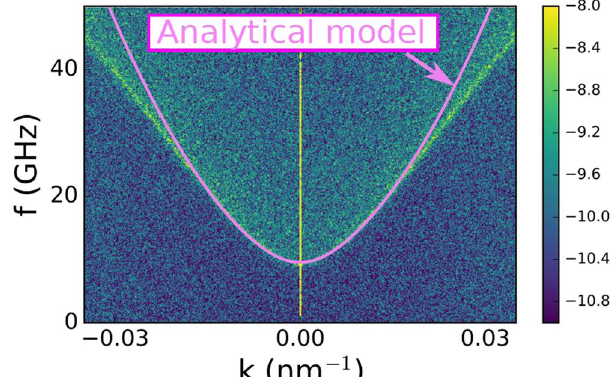
Figure 8. Simulations (color scale of the 2D FFT amplitude, a.u.) and analytic calculation (line) of the dispersion relation of spin waves propagating in a semi-infinite (periodic boundary conditions in one direction) plane, 1 nm thick (to allow a comparison with the analytical model, which requires small thicknesses), with a 60° Néel domain wall localized at the boundary. The bias magnetic field is H = 1000